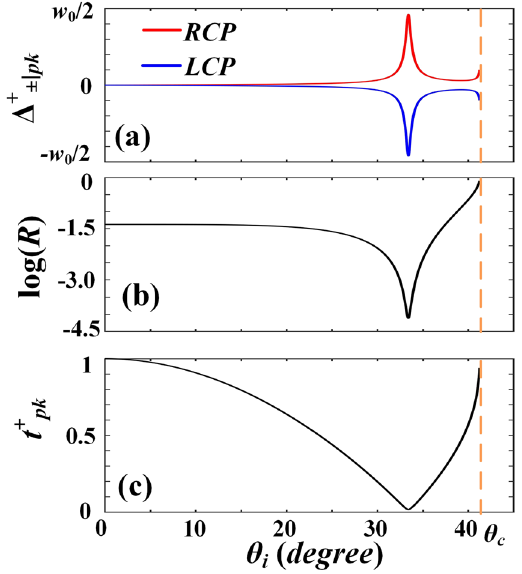
Figure 2. The changes of the peak displacements θ ∆ ±+ ( ) ( b ), and the required initial amplitude ratio θ + t ( ) n =